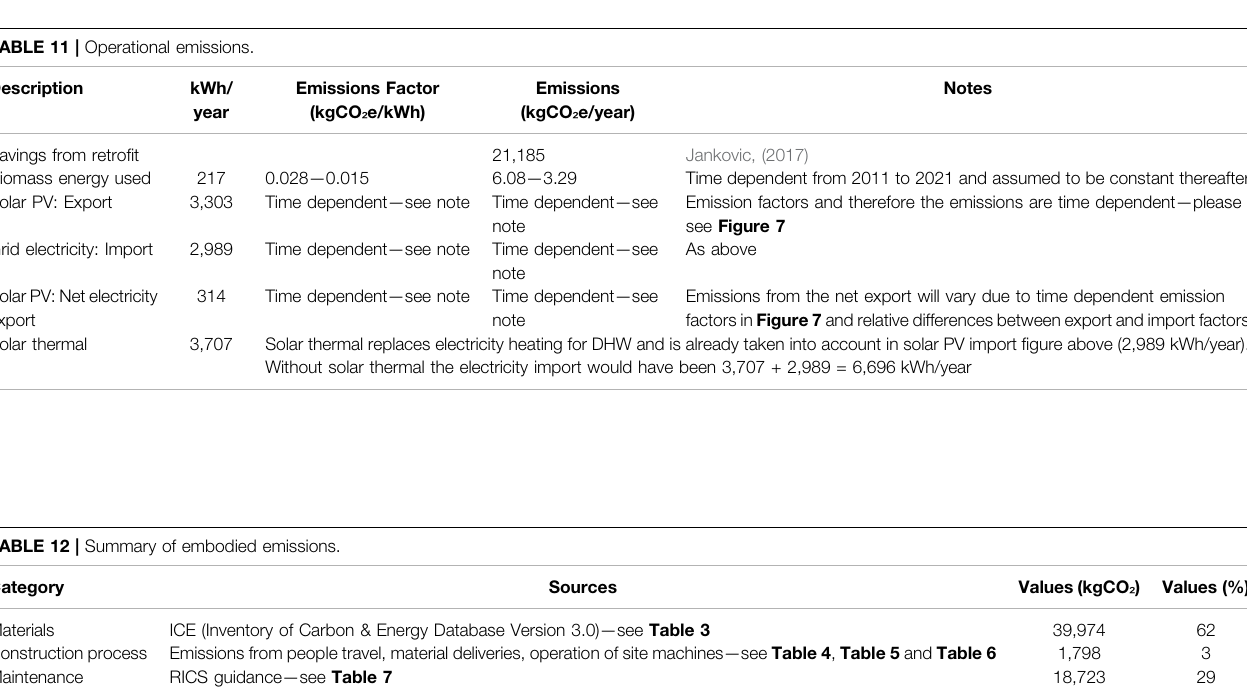
RICS guidance: demolition ( Table 8 ), transport ( Table 9 ), and disposal ( Table 10 )